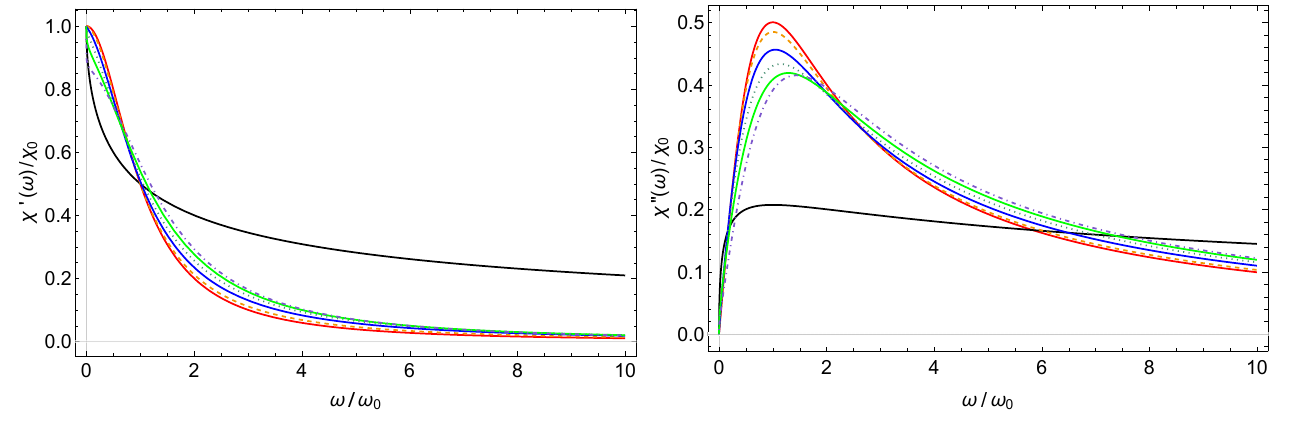
Figure 3. Behaviour of the complex susceptibility as obtained from our solution for the mixed Debye and Cole–Cole relaxation processes. Red lines correspond to pure Debye relaxation, while black lines represent Cole–Cole relaxation for the value α = 0.5. The parameters are a 1 = 0.8 and a 2 = 0.2, respectively. Dashed lines correspond to α = 0.9, blue lines correspond to α = 0.7, dotted lines correspond to α = 0.5, green lines correspond to α = 0.3, and the dot-dashed ones correspond to α = 0.1. Left panel : real part. Right panel : imaginary part (dielectric